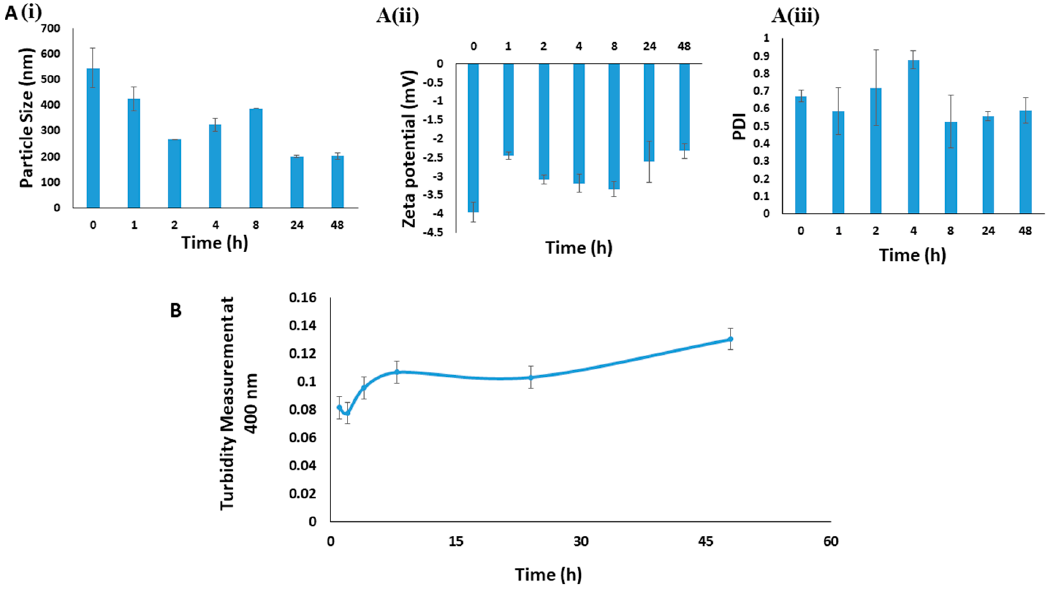
Figure 11. Systemic and physical stability analysis based on A ( i ) particle size, A ( ii ) PDI and A ( iii ) Zeta potential of Blank NaCNs for two days at 37 °C ( B ) Turbidity measurement of NaCNs for two days at 37 °C.